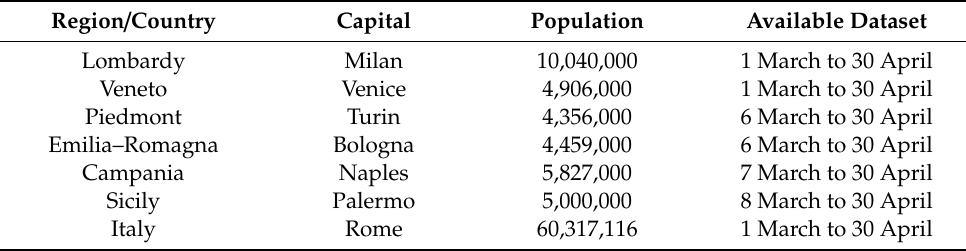
Figure 2. Location of the selected case studies [36–38]. Table 1. The selected case studies in Italy